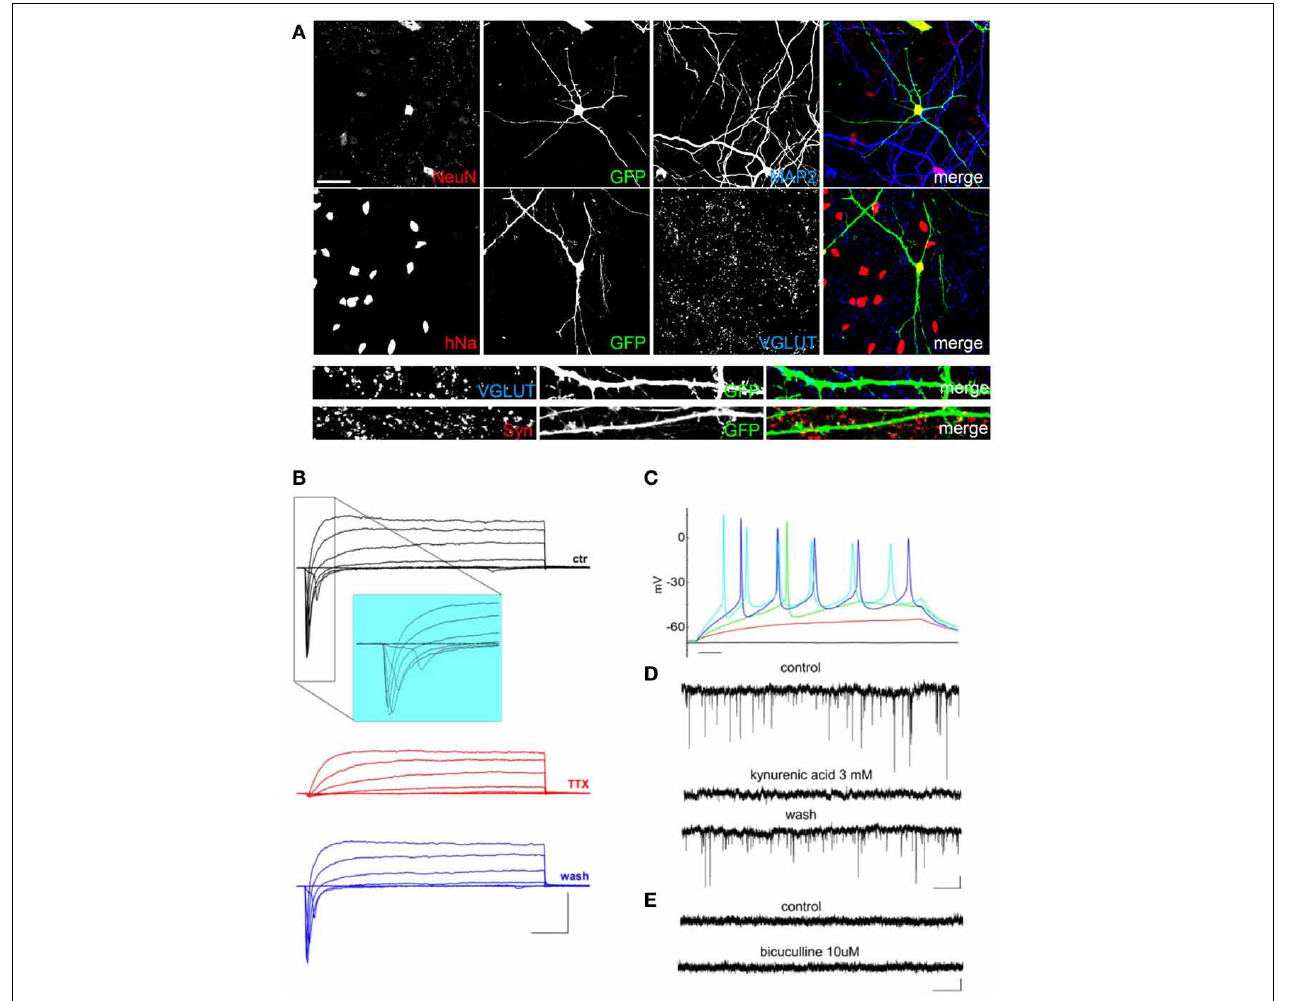
FIGURE 3 | Characterization of hNP-derived neurons differentiated by coculture on E18 rat primary cortical neurons. (A) hNP-derived neurons are positive for MAP2 and hNA and are also positive for the mature neuronal markers NeuN (red, top, scale bar 50 μ m), VGLUT (blue), and synaptophysin (red, bottom, scale bar 15 μ m). (B) Representative total ionic current traces recorded with depolarizing voltage steps between-70 and + 10mV (10mV increments from a holding potential of − 70mV) from hNP-derived neurons. From top to bottom: currents in control (black), with perfusion of tetrodotoxin 1 μ M (red) and after washout (blue). Scale bars, 10ms, 1000pA. The inset shows an enlargement of the traces in control, for better displaying voltage gated sodium currents. (C) Representative firing traces recorded from